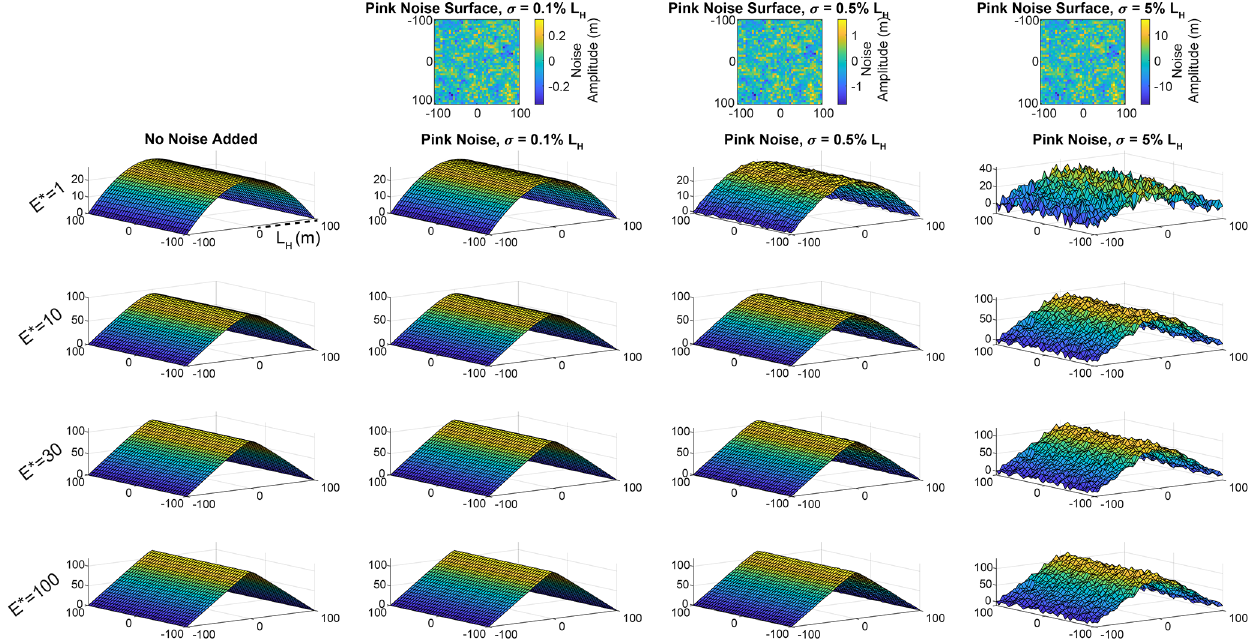
Figure 8. Synthetic hillslopes constructed using Eq. (11). Upper row shows pink noise surfaces that are added to the original hillslope form (left column); yellow colors correspond with positive deviations from the hillslope (convex noise) and blue with negative deviations (concave noise). Each row of hillslopes corresponds with range of dimensionless erosion rates, from E ∗ = 1–100. Note the increased prominence of planar hillslopes as E ∗ increases; the z axis on each plot may differ. Noise does not vary with E ∗ ; thus the magnitude of noise relative to hillslope relief is more visually apparent at lower E ∗ (see σ = 5% L H column for clear example). Note that all results in Fig. 10c, g, k, and o correspond with the third column here ( σ = 0 . 5% L H ). See the Supplement for corresponding figures for σ = 0 . 1% L H and σ = 5% L H